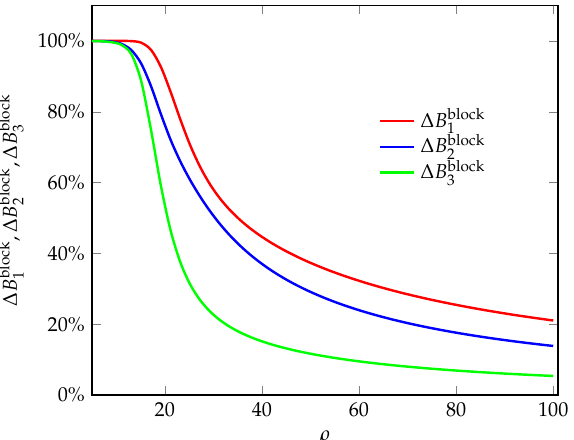
Figure 9. The percentage decrease in the blocking probabilities for arriving requests vs. the of- fered load.